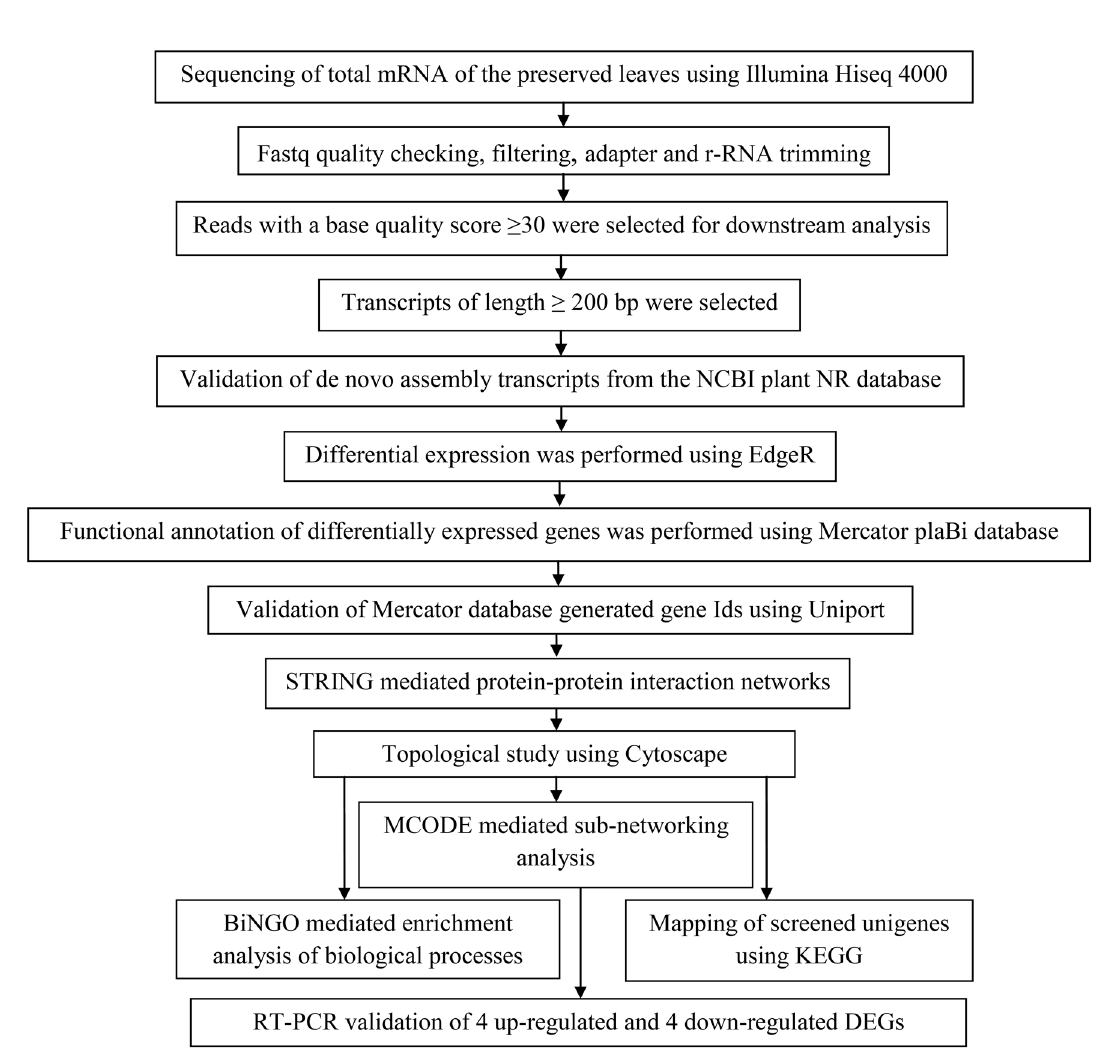
Figure 3. Flowchart describing the steps of data procession and subsequent analysis of differentially expressed